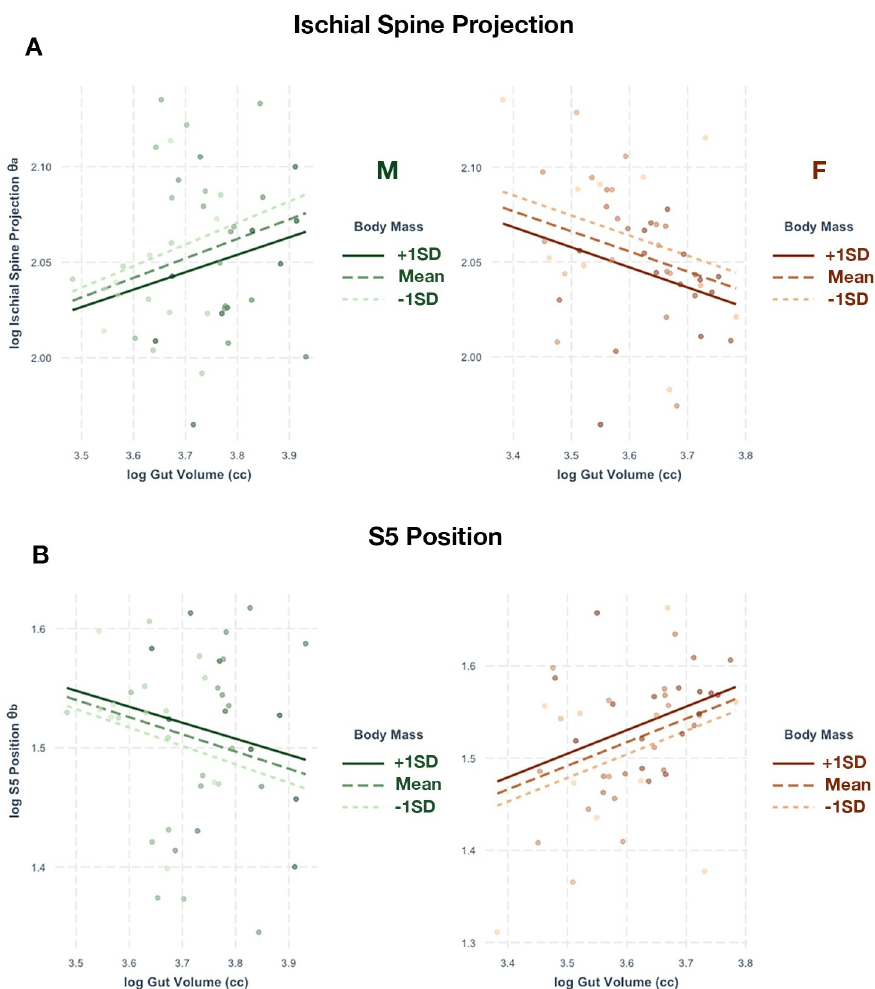
Fig 5. Relationship of ischial spine and S5 position with gut volume. Regressions between gut volume and (A) ischial spine projection ( θ a ) and (B) S5 apex position ( θ b ) relative to body mass. A lower θ a indicates more medially- projecting ischial spines. A higher θ b indicates a longer distance between the ischial spines and the S5 apex. The left column (green) represents the male sample and the right column (orange) represents the female sample. Only the female regression models were